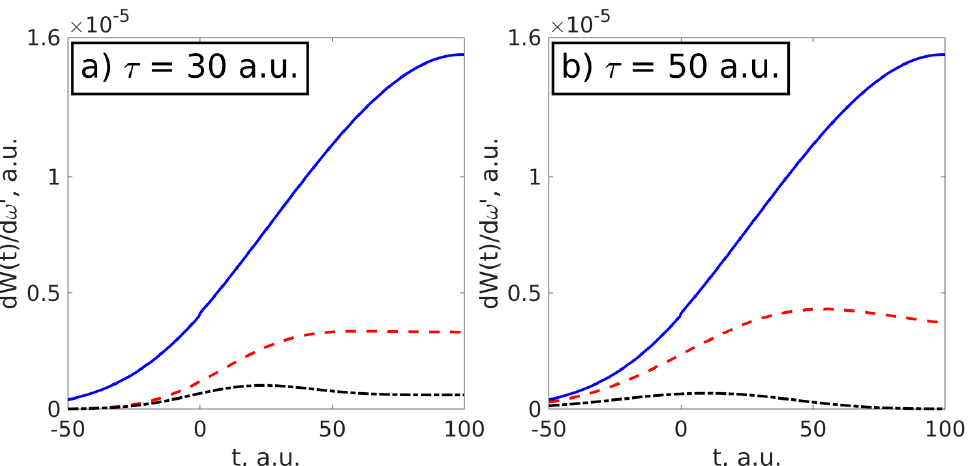
Figure 2. Time dependence of spectral scattering probability at different frequencies of scattered radiation. Solid line— ω (cid:48) = 20 a.u., dashed line— ω (cid:48) = 20.025 a.u., dash-dot line— ω (cid:48) = 20.05 a.u. Carrier frequency— ω = 20 a.u.